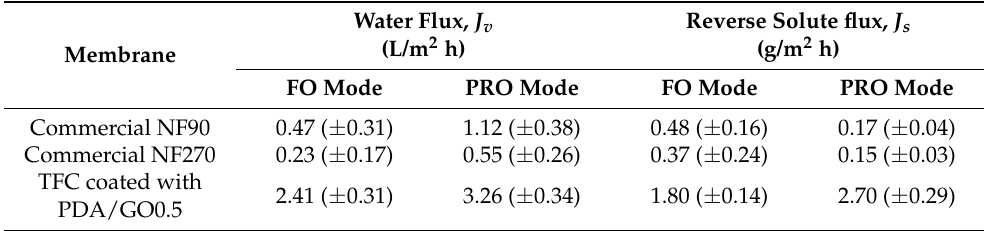
Table 7. Performance comparison between commercial membranes and best performing TFC mem- brane developed in this work for AT-POME treatment in FO and PRO mode. Water Flux, J v Reverse Solute flux, J s (L/m 2 h) (g/m 2 h) Membrane FO Mode PRO Mode FO Mode PRO Mode Commercial NF90 0.47 ( ± 0.31) Commercial NF270 TFC coated with